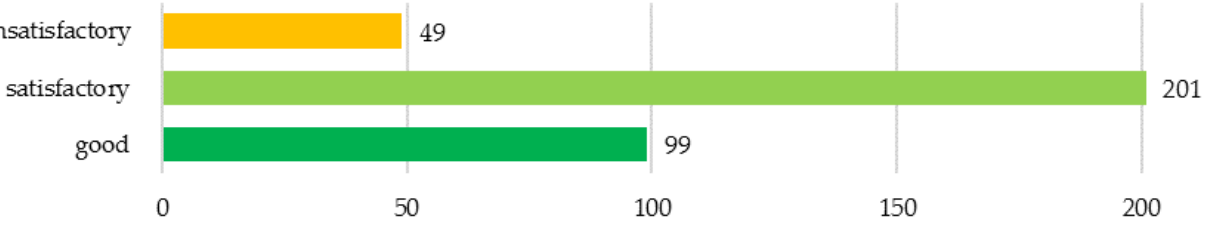
Figure 15. Transformer state